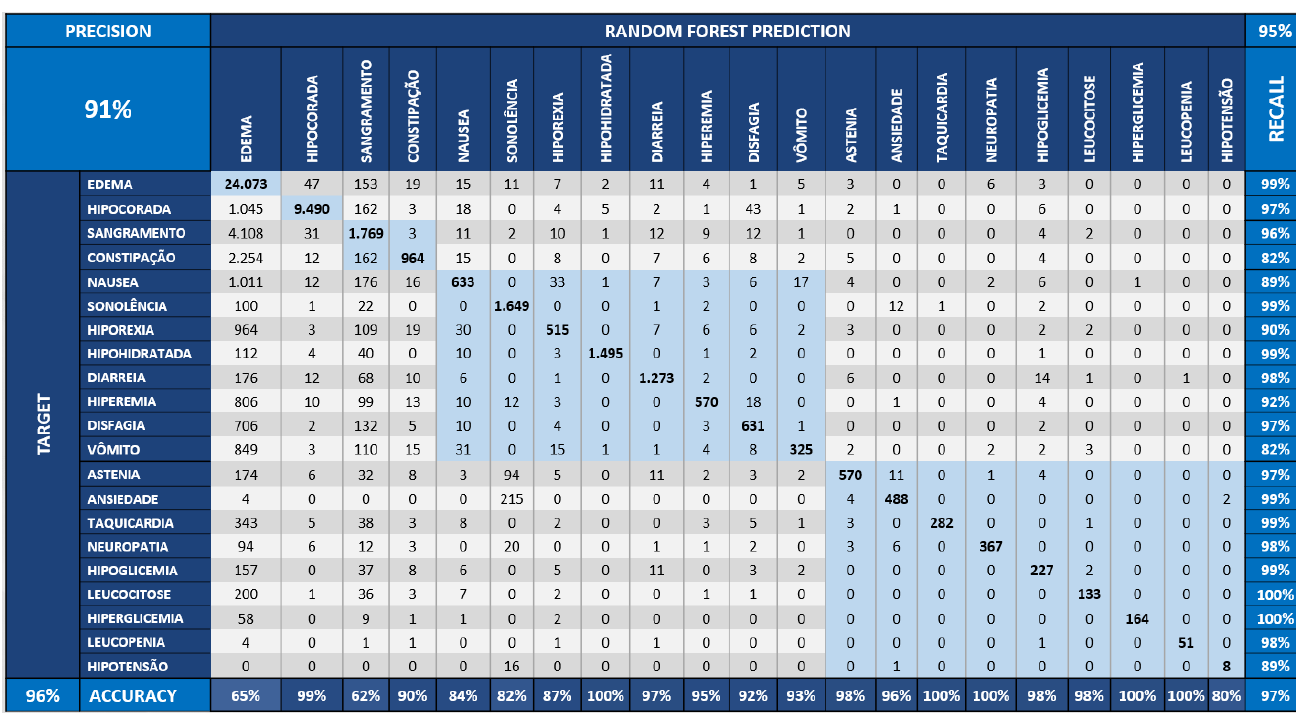
Figure 14. Benchmark 2—Base Model + CI.